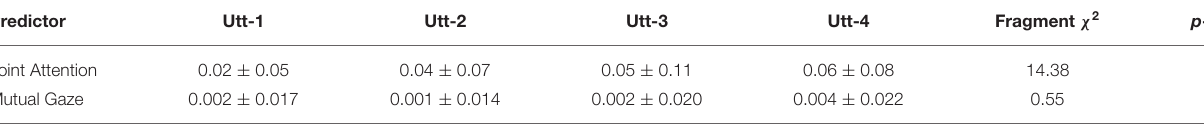
TABLE 6 | LMM on group attention features in Fragment (Utt1-Utt4) fixed factor. Predictor